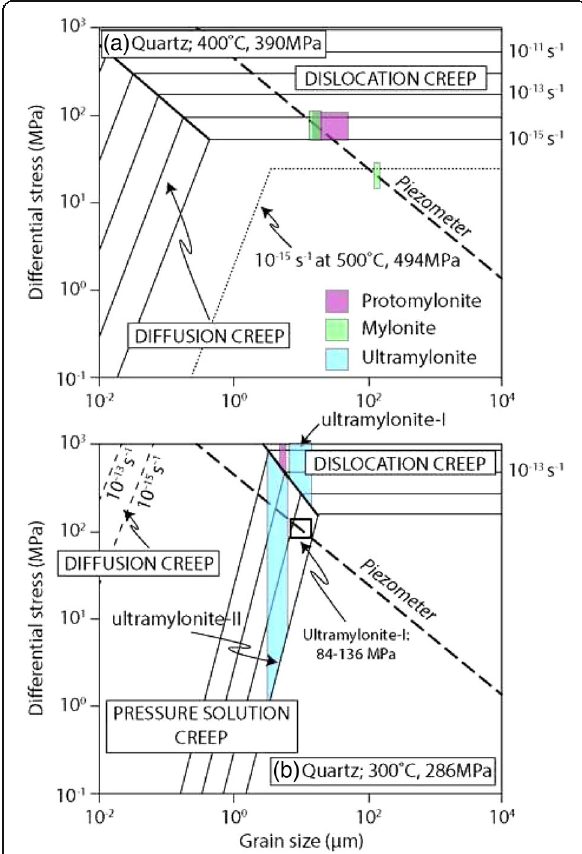
Fig. 11 Deformation mechanism maps for quartz under approximate conditions of deformation of the protomylonite – mylonite ( a ; temperature = 400 °C, confining pressure = 390 MPa) and ultramylonite ( b ; temperature = 300 °C, confining pressure = 286 MPa). The exterior mylonite likely deformed at a higher temperature than the other samples — indicated by a 10 − 15 s − 1 strain rate contour at 500 °C (dotted line). The piezometer of Cross et al. (2017) is indicated by the dashed line. Dashed lines in ( b ) represent strain rate contours for Nabarro – Herring diffusion creep. The calculated differential stresses for ultramylonite-I are indicated by the black outline in ( b